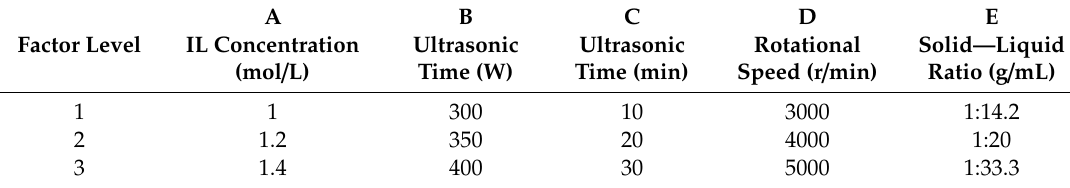
Table 1. Orthogonal test factors and level tables.